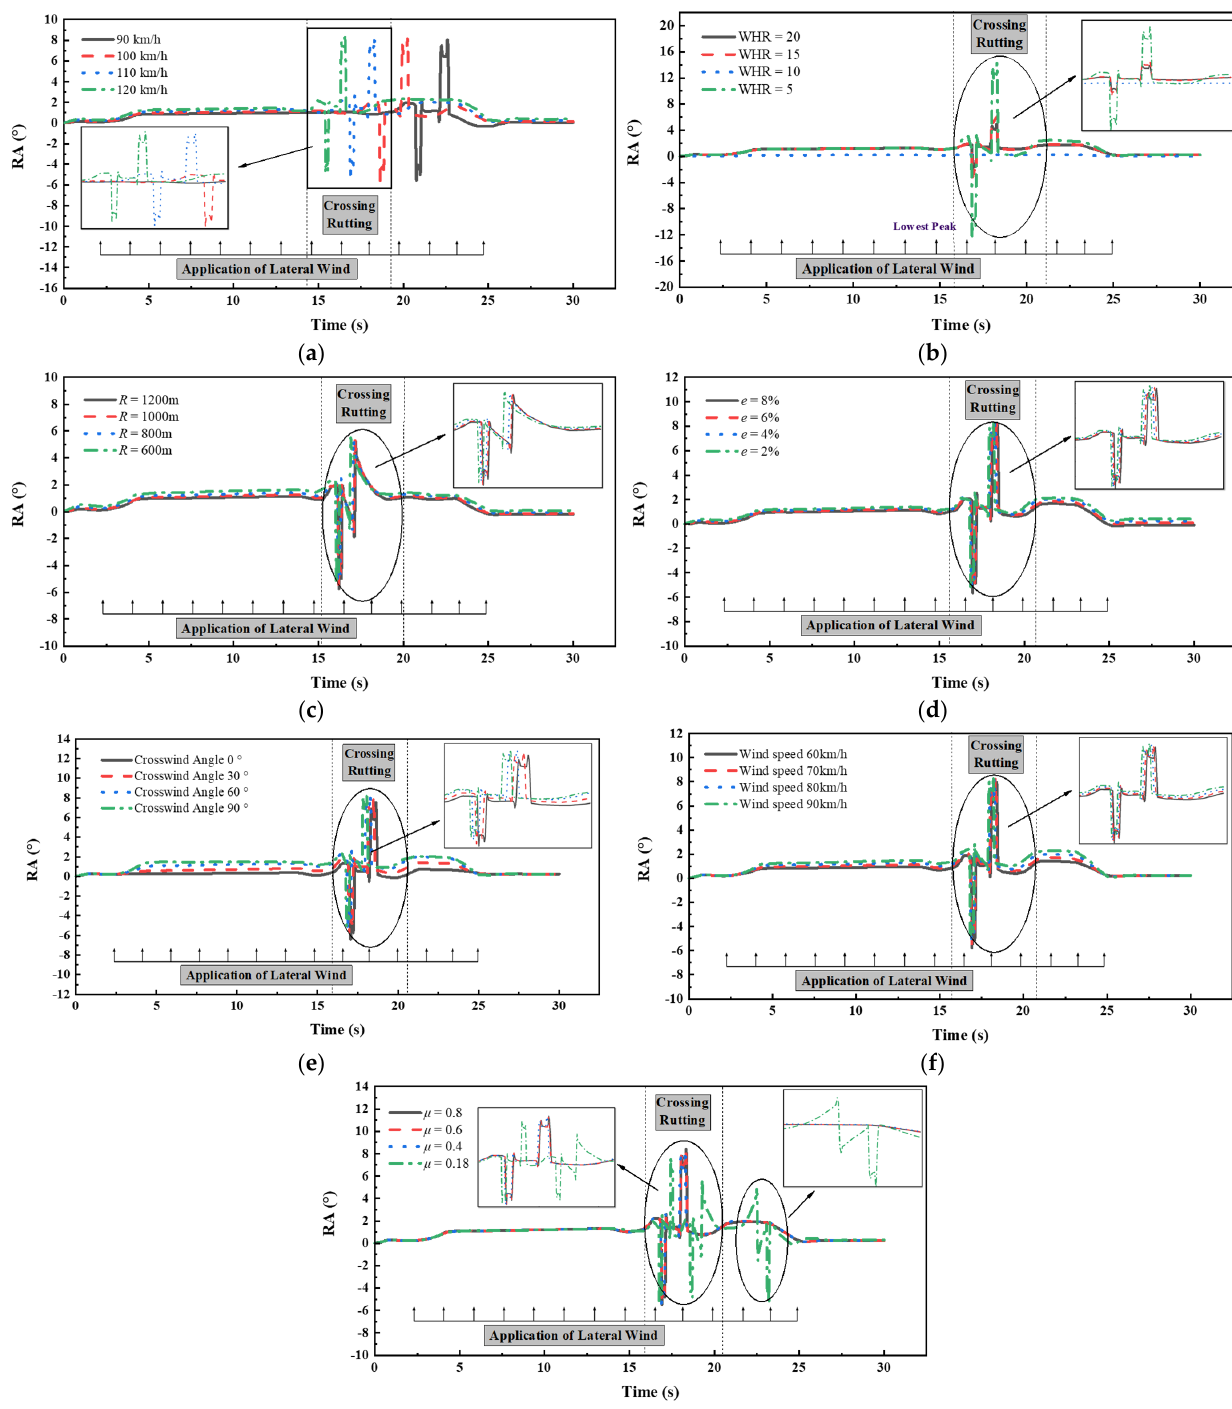
Figure 11. Change of RA over time under various driving conditions: ( a ) Vehicle speed; ( b ) WHR of the rutting; ( c ) Radius of circular curve; ( d ) Superelevation; ( e ) Crosswind angle; ( f ) Wind speed; ( g ) Friction coefficient between road & tire.